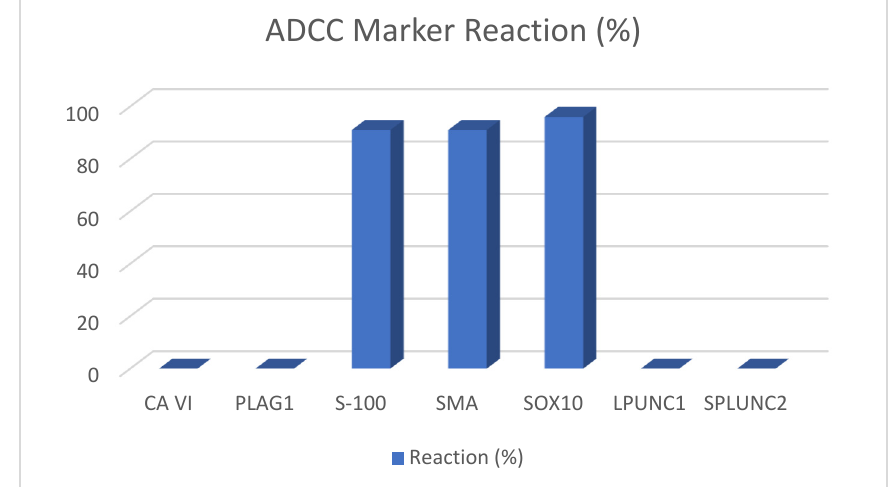
Figure 4. ADCC marker reaction.